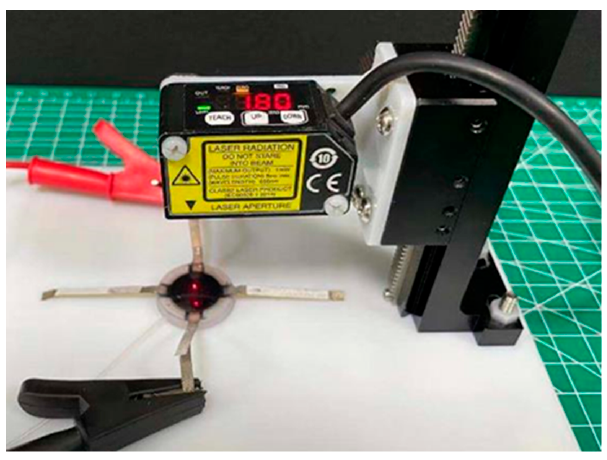
Figure 4. The output displacement measurement of the SEHPA.